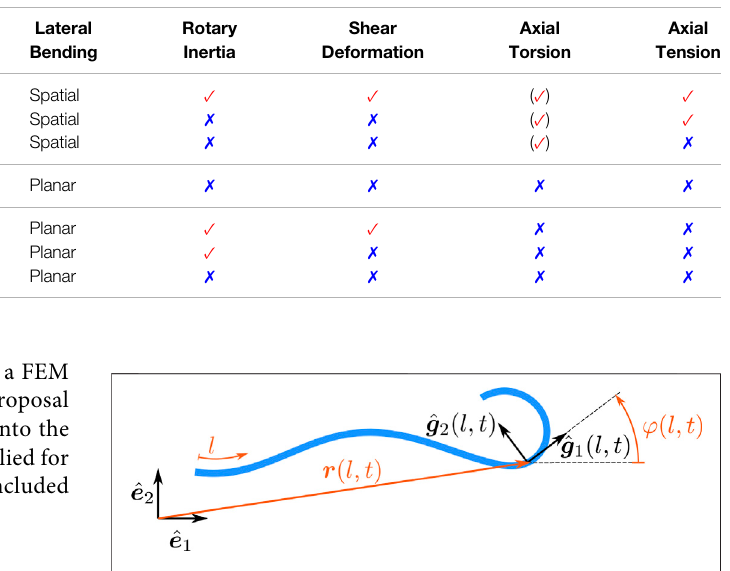
TABLE 1 | Comparison of this work to the most commonly used beam theories. While the proposed model is limited to planar bending, it offers a geometrically exact description in a single-dimensional equation.